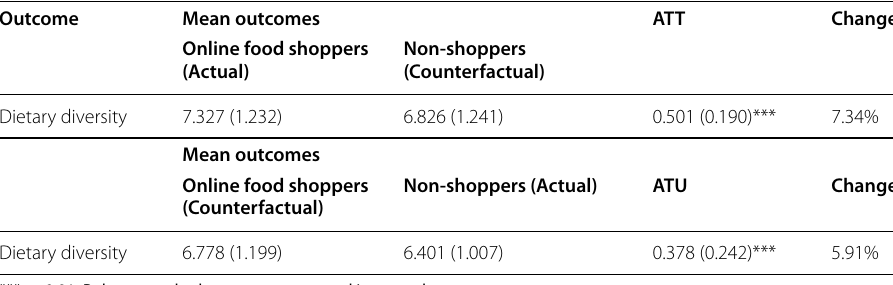
*** p < 0.01. Robust standard errors are presented in parentheses ATT: average treatment effects on the treated, ATU: average treatment effects on the untreated